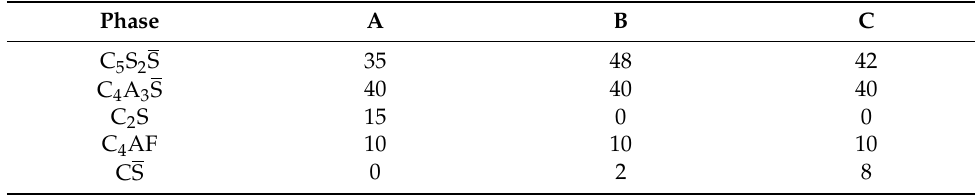
Table 2. Theoretical mineralogical compositions of the TCSA clinkers (wt.%).